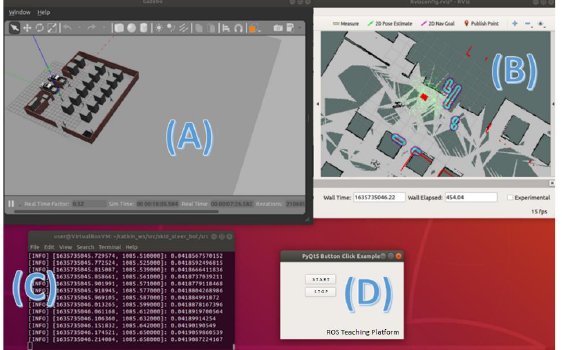
Figure 4. The proposed platform running a simulation: Gazebo render map ( A ), RVIZ planning map ( B ), data of robot measurements in real time ( C ), and user GUI ( D